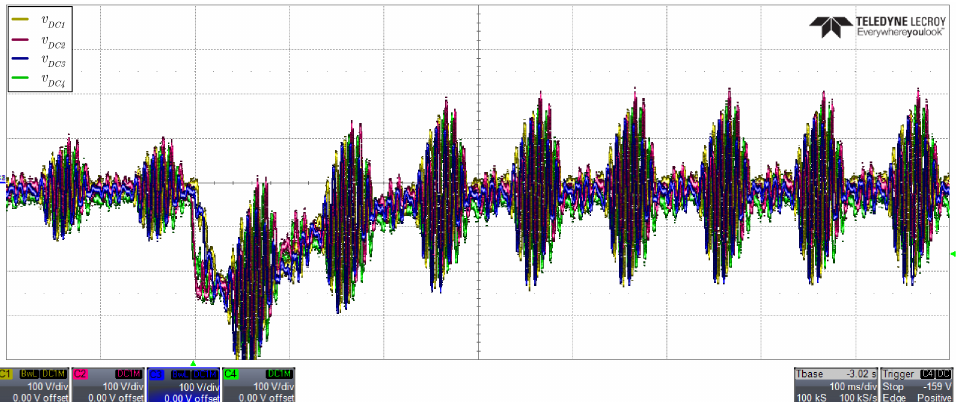
Figure 18. Transient response showing the DC bus voltages for a step from 50% to 100% in the power injected in the port 2 of the converter.